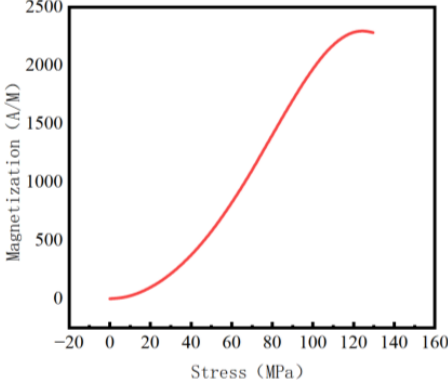
Figure 1. Stress-magnetization curve.